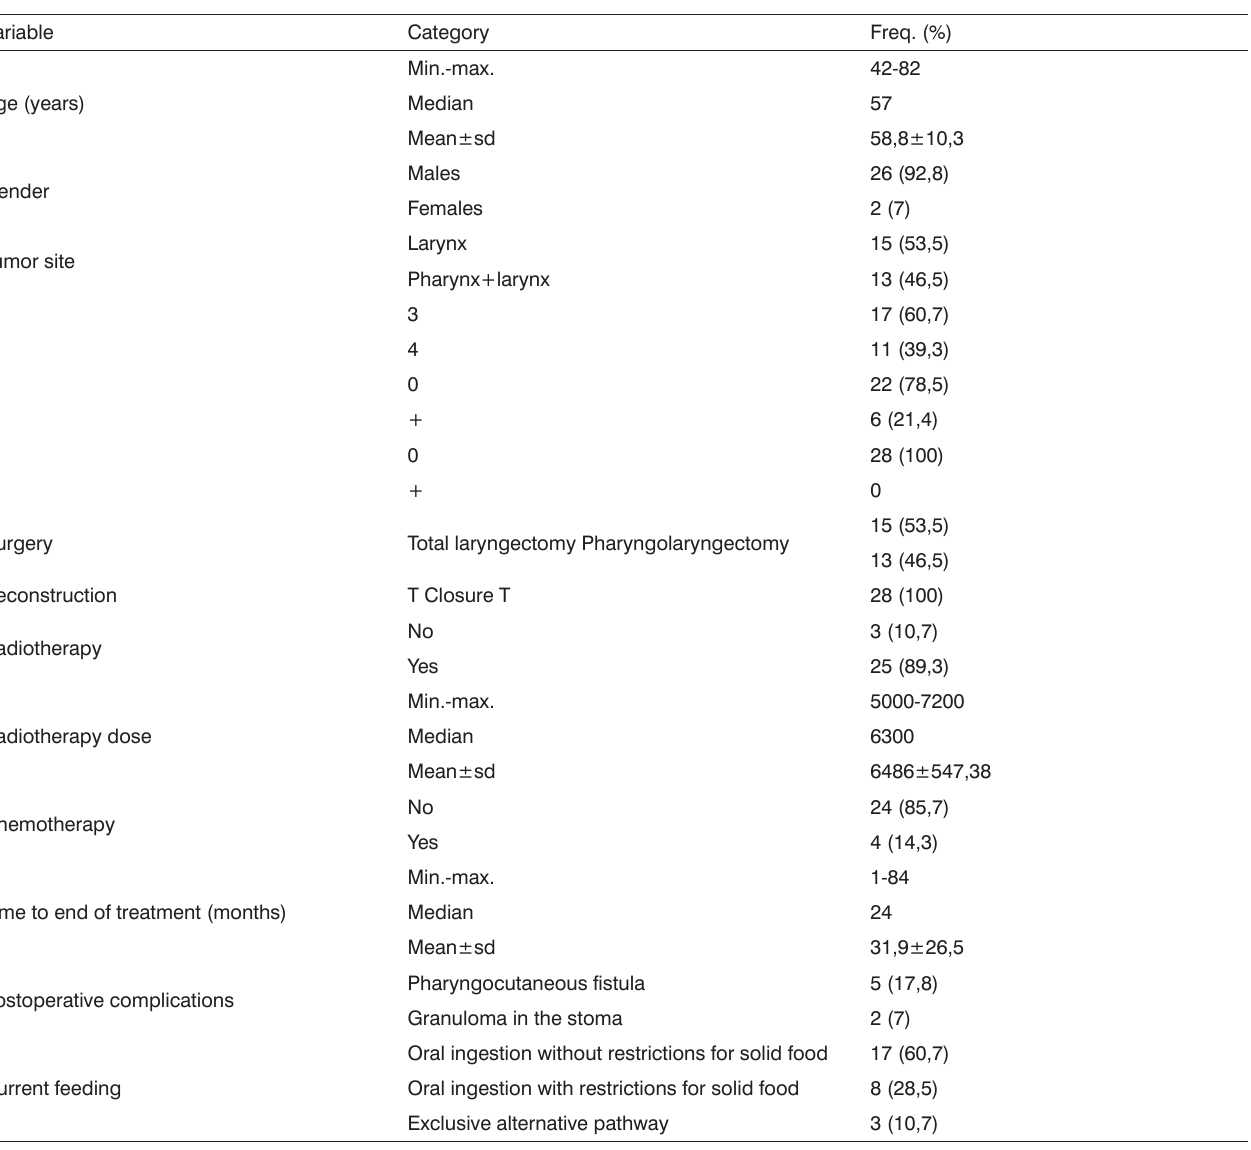
Table 1. Demographic, clinical and treatment characteristics. (N=28)